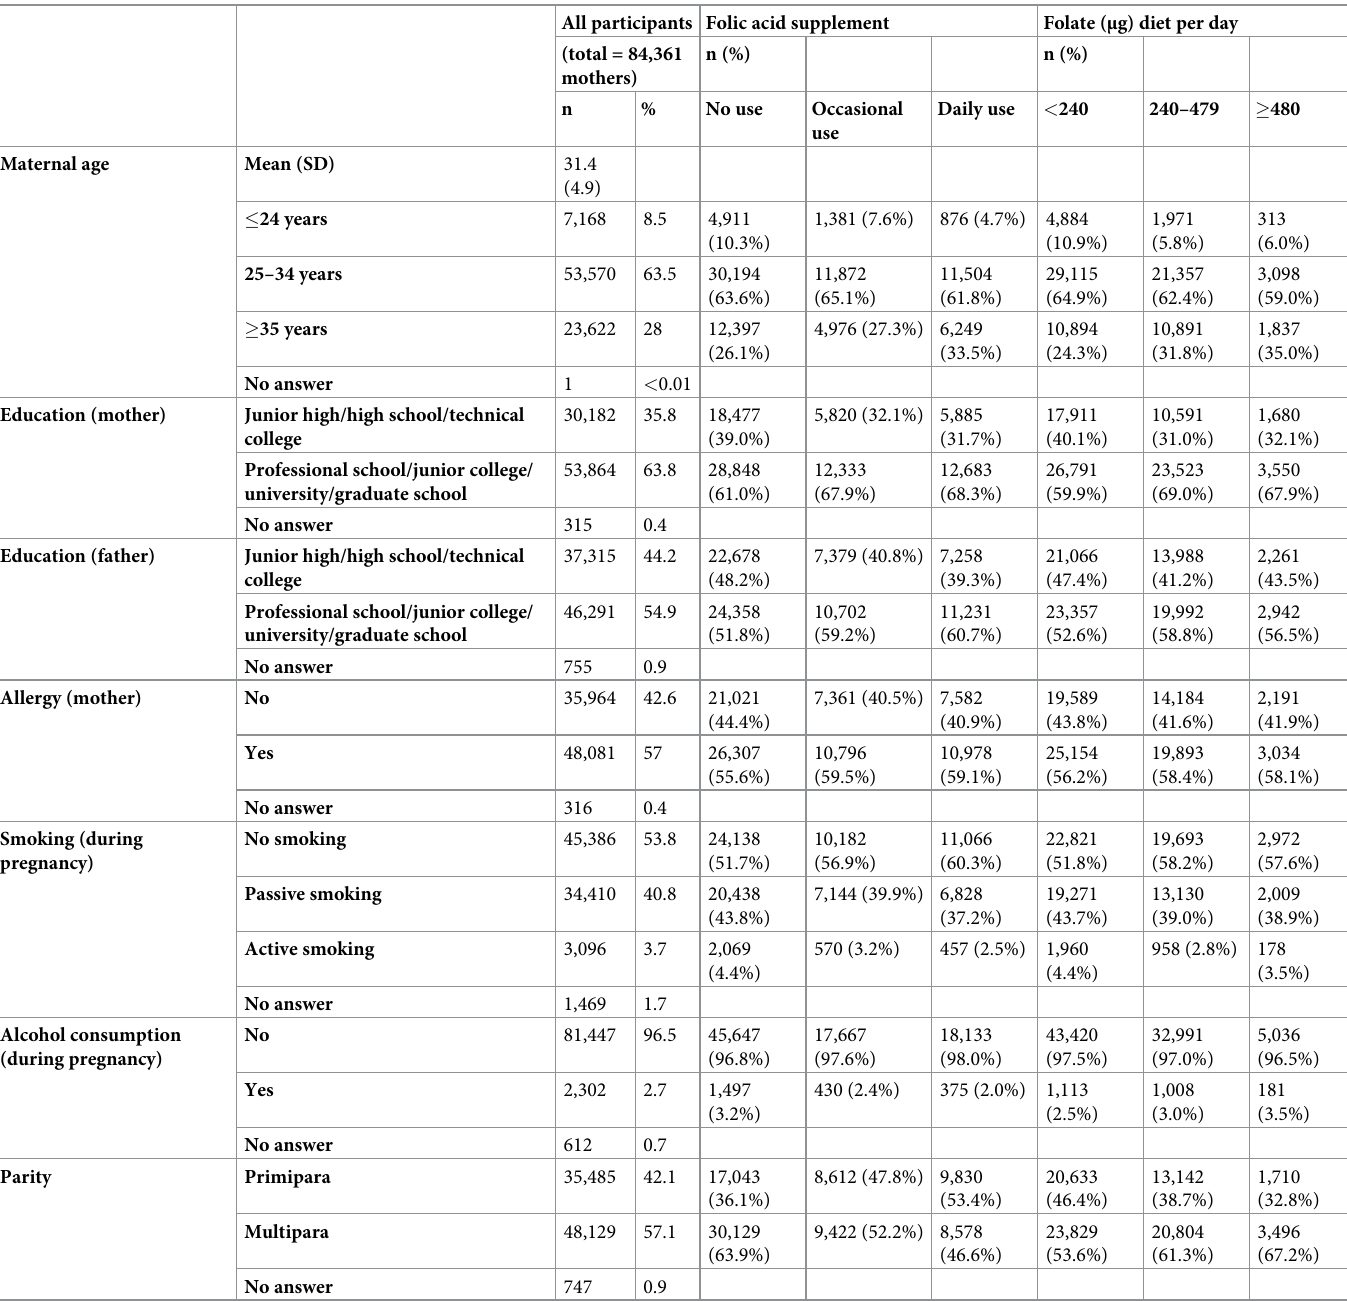
Table 1. Characteristics of the participants